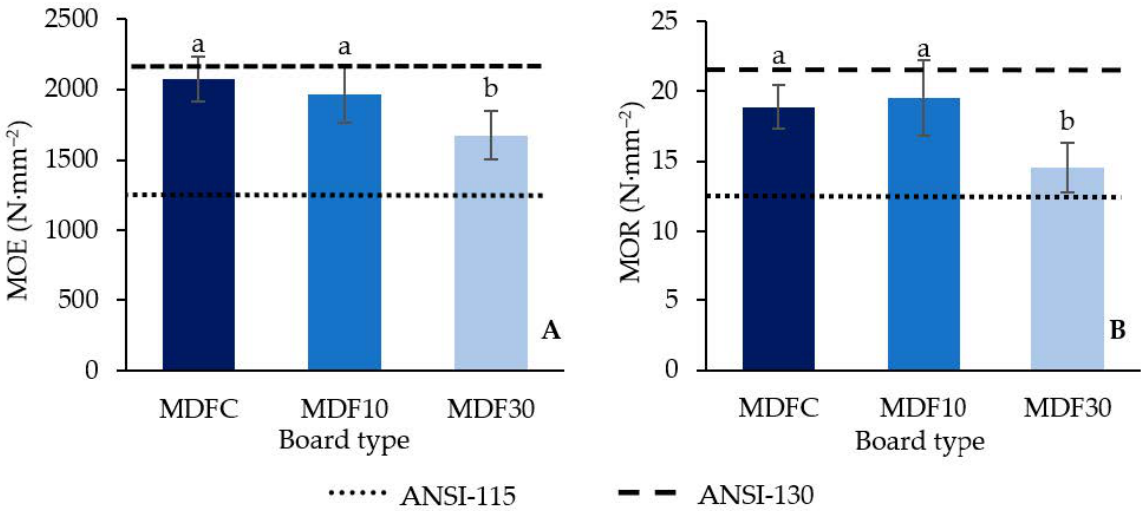
Figure 5. ( A ) Modulus of elasticity of MDF panels. p value of ANOVA for modulus of elasticity is 9.84 × 10 − 5 . ( B ) Modulus of rupture of MDF panels. p value of ANOVA for modulus of rupture is 6.50 × 10 − 6 . Different lowercase letters represent statistically significant difference among panels by Tukey test ( p ≤ 0.05). Dotted lines represent MDF standard requirement for 115 and 130 grades ac- cording to ANSI A208.2-2016.